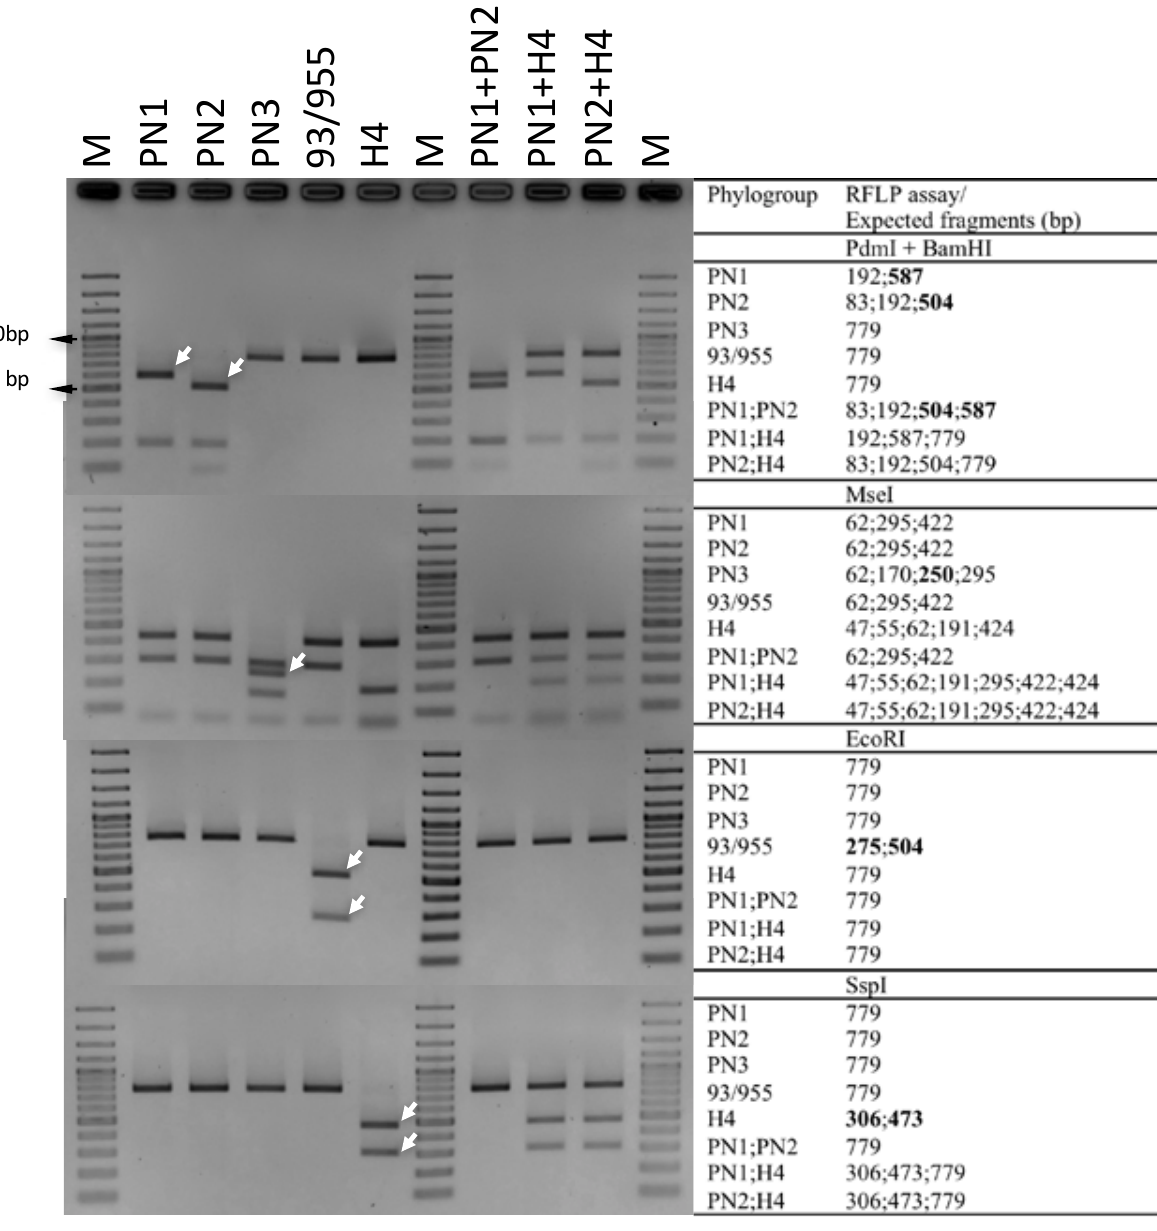
Figure 3. Reverse-transcription followed by polymerase chain reaction and restriction length polymorphism (RT-PCR- RFLP) analysis of capsid protein gene fragments obtained from isolates of Grapevine leafroll-associated virus 2 (GLRaV-2), composed of variants from phylogroups PN1, PN2, PN3, 93/933 H4, and mixed infections with PN1+PN2, PN1+H4 and PN2+H4. DNA fragments were digested with enzymes A – PdmI and BamHI, B - MseI, C -EcoRI and D – SspI, and resolved on 2% agarose gel. Lane M shows GeneRuler 100 bp Plus DNA Ladder 100 to 3000 bp (Thermo Scientific Inc., USA) for estimating the size of the DNA fragments obtained – the size of the bands corresponding to 500 and 1000 bp fragments of the markers are indicated to the left. The typification fragments for each phylogroup are indicated by arrows on the gel and also in bold in the table on the